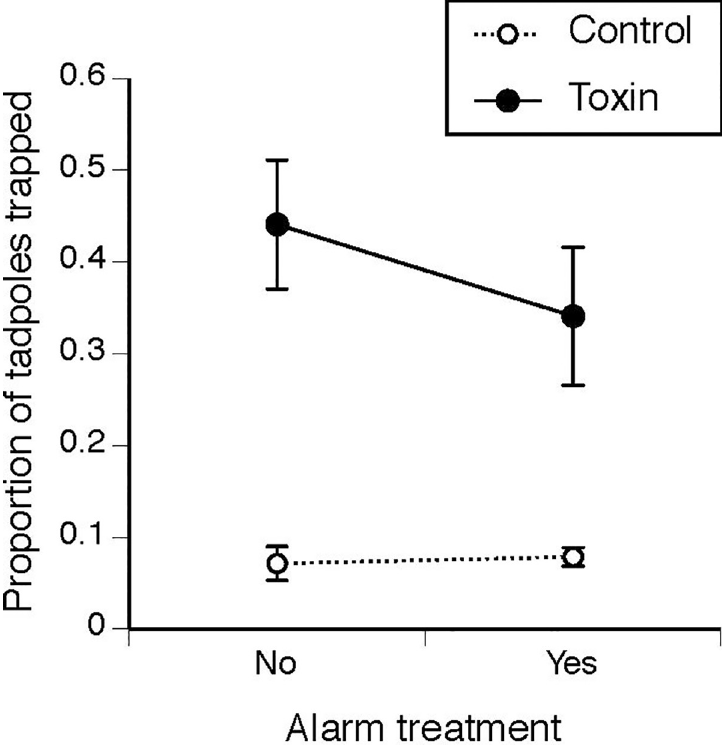
Fig 4. The proportion of alarm-treated and non-alarm-treated cane toad tadpoles ( Rhinella marina ) captured in funnel traps after 90 min, when traps were baited with either 200 mg of adult toad toxin or unchlorinated bore water (n = 7–11). Alarm-treated tadpoles were exposed to freshly crushed conspecifics daily for 7 days before testing. The graph shows mean values ± SE.